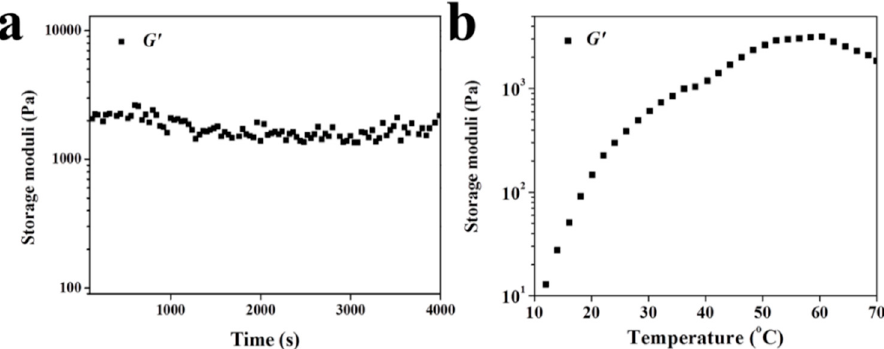
Figure 3. ( a ) G ′ as function of time for fibrin gel and ( b ) G ′ of PLGA − PEG − PLGA hydrogel versus increased temperature.